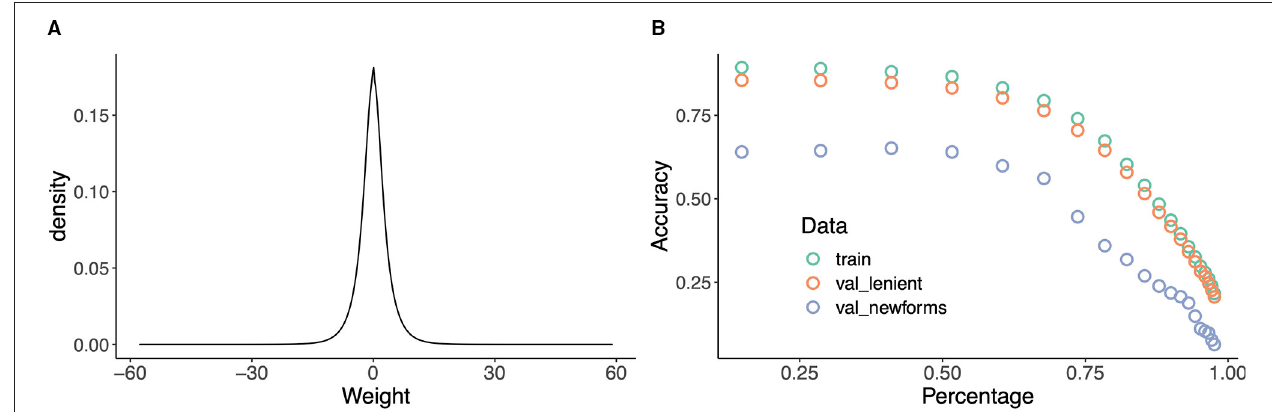
FIGURE 5 | (A) Distribution of weights in the mapping matrix from form to meaning for the dataset with semantic roles. (B) Accuracy of the end-state model as a function of the proportion of connection weights close to zero are pruned. About 40% of the weights can be set to zero without seriously affecting the performance of the